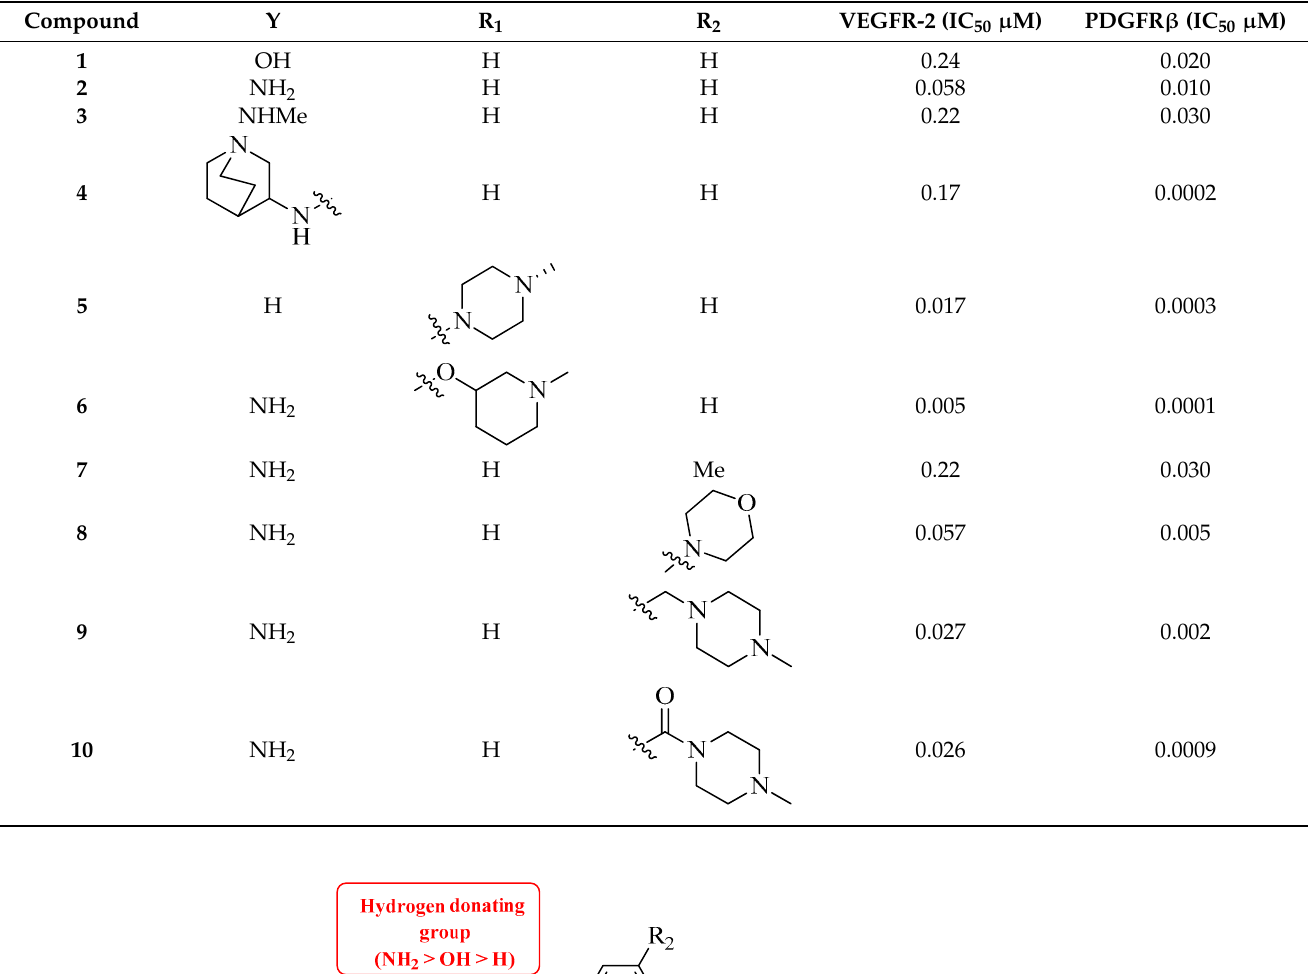
Table 1. In vitro inhibition of vascular endothelial growth factor receptor 2 (VEGFR-2) by the quinolin-2-one analogues ( 1 – 10 ) [41].